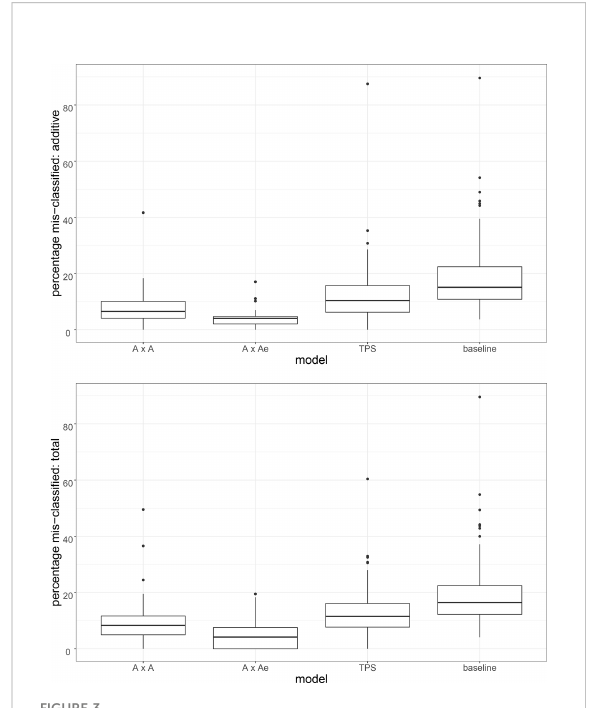
FIGURE 3 For the A×A, A×Ae, TPS and baseline models, a boxplot summary of the percentage of entries in the selection set (top ranking 20% of entries for each trial based on e-BLUP) that are mis-classi fi ed by that model when compared to the best model. Plots are for the additive effects (top plot) and total effects (bottom plot). For each model, trials for which that model was the best fi tting model have been excluded from the